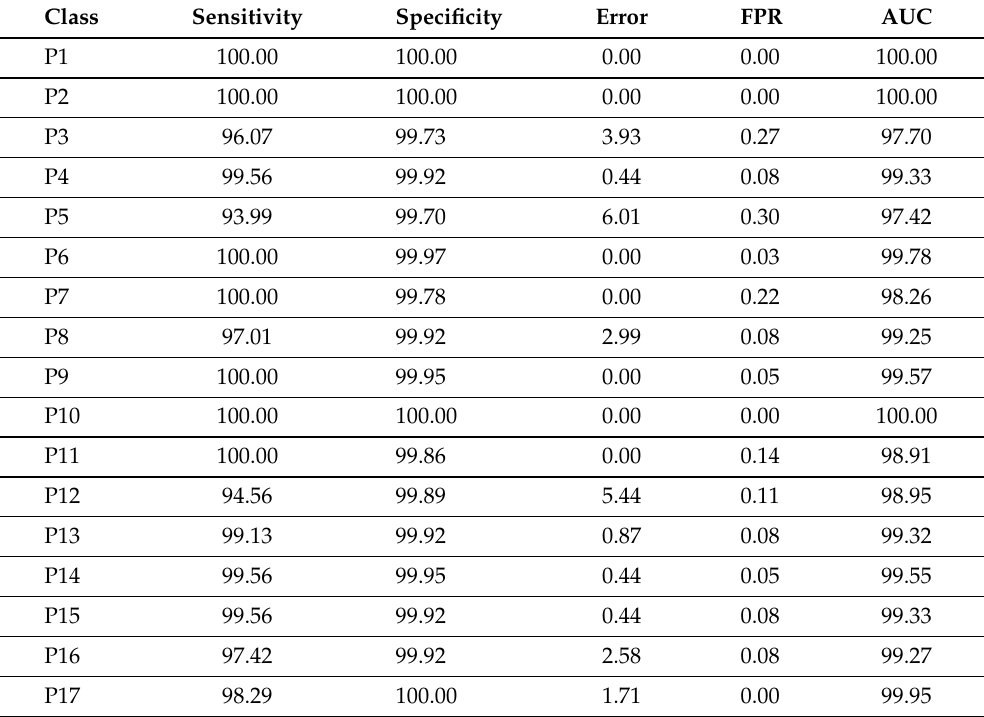
Table 6. Performance metrics (in percent) obtained with the SVM model and the All Features set. The model was trained using vibration signals in channel A1 from the RC